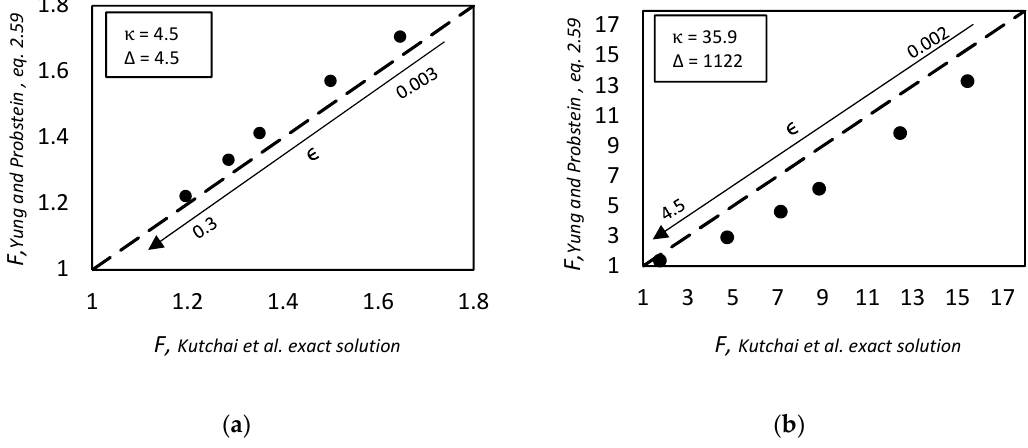
Figure 3. Comparison between facilitation factor F calculated numerically by Kutchai et al. [53] and the value calculated by Equation (86) proposed by Yung and Probstein [90] for different values of 𝜖 and 𝜅 and Δ fixed. ( a ) 𝜅 = 4.5, Δ = 4.5; ( b ) 𝜅 = 35.9, Δ = 1122. Dashed lines represent the parity condition.